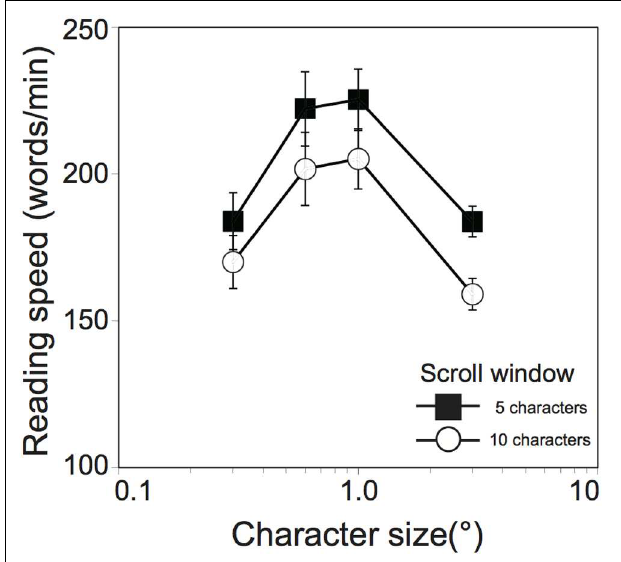
FIGURE 2 | Reading speed (ms/word) as a function of character size ( ◦ ) in Experiment 1 ( N = 10). Filled squares and open circles indicate scrolling window size of 5 and 10, respectively. Error bars denote the standard error of the